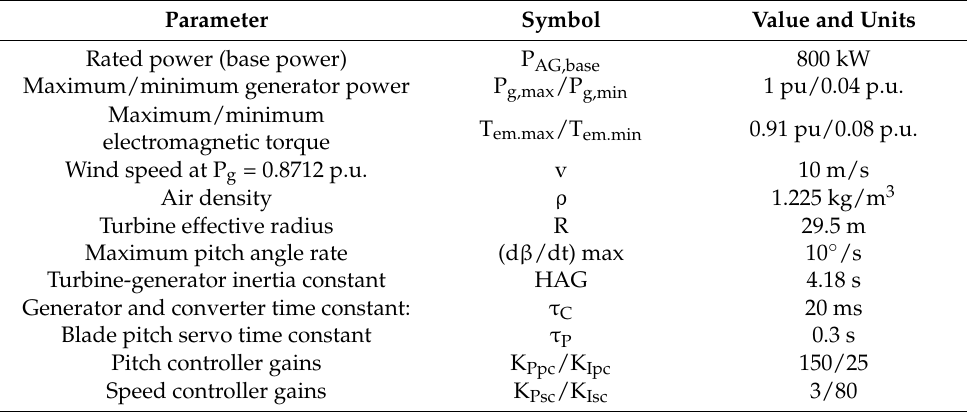
Table A2. Parameters of the MADE A-59 wind turbine model